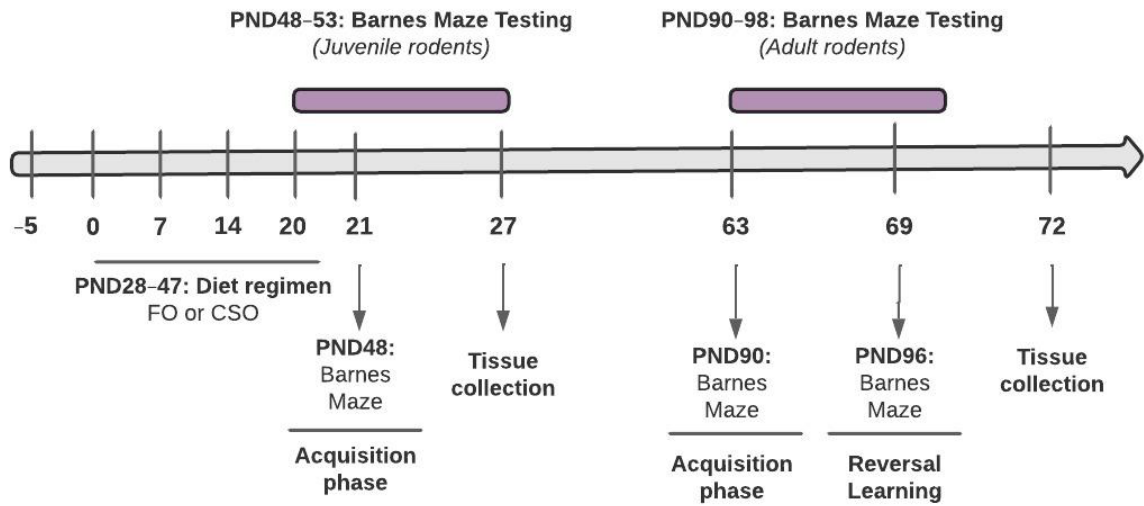
Figure 1. Experimental Timeline. Animals arrived at the facility on PND23 and acclimated for 5 days prior to the start of the experiment. Dietary supplementation occurred daily from PND28 to PND47 (20-day period). Half the cohort underwent Barnes Maze testing immediately following the supple- mentation period ( n = 32), while the other half was tested as they reached adulthood (PND90). Barnes Maze acquisition was evaluated for 6 days in adolescent and adult rats, while reversal learn- ing was assessed in adults only for 3 days. FO: Menhaden fish oil; CSO: Control soybean oil.